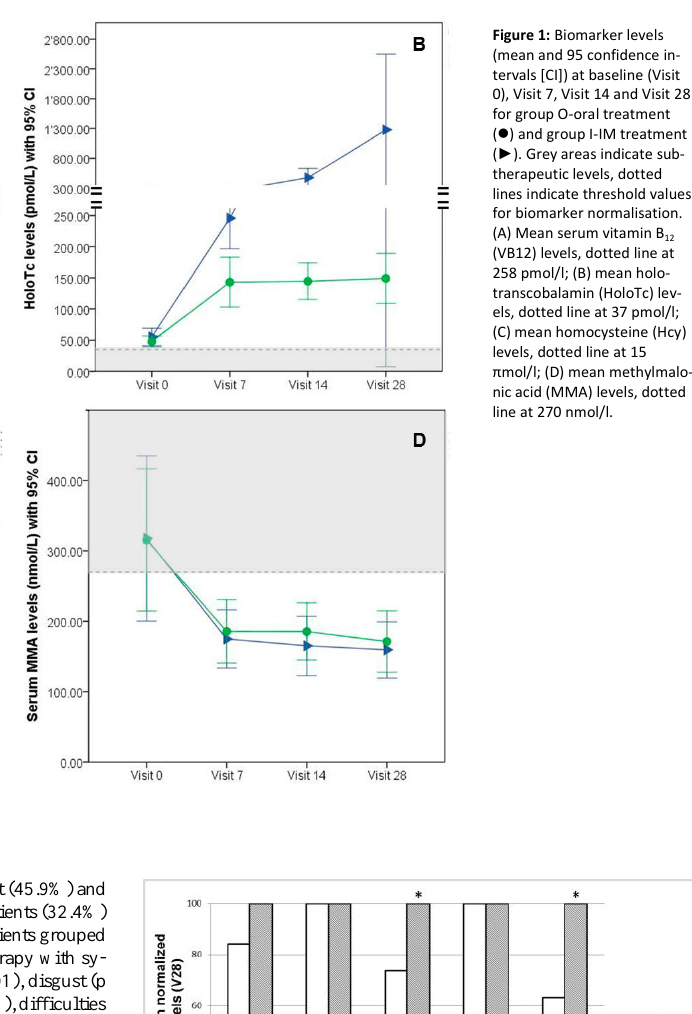
Figure 1: Biomarker levels (mean and 95 confidence in- tervals [CI]) at baseline (Visit 0), Visit 7, Visit 14 and Visit 28 for group O-oral treatment (  ) and group I-IM treatment ( ► ). Grey areas indicate sub- therapeutic levels, dotted lines indicate threshold values for biomarker normalisation. (A) Mean serum vitamin B 12 (VB12) levels, dotted line at 258 pmol/l; (B) mean holo- transcobalamin (HoloTc) lev- els, dotted line at 37 pmol/l; (C) mean homocysteine (Hcy) levels, dotted line at 15 πmol/l; (D) mean methylmalo- nic acid (MMA) levels, dotted line at 270 nmol/l.